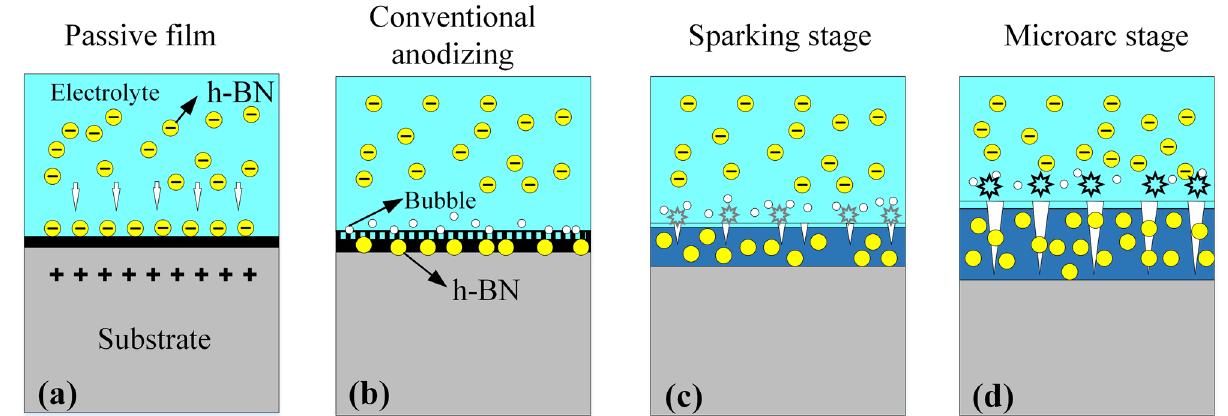
Figure 10. Deposition mechanism of h-BN